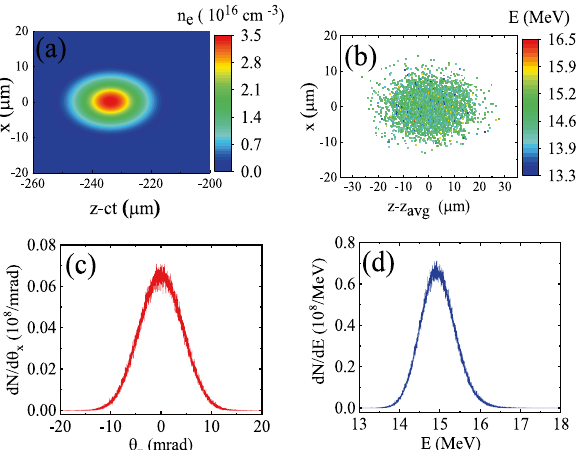
Figure 2. ( a ) Density distribution of a 15 MeV bi-Gaussian witness electron beam with the peak density n = 3.5 × 10 16 cm − 3 , which is initially placed 200 μm behind the peak of the laser pulse. The radii of the b0 injected bunch in the longitudinal and transverse directions are σ z = 8 μm and σ x = 4 μm, respectively; ( b ) Spatial distribution of the electron bunch injected in the simulations; ( c ) Distribution of the inclination angle θ x ; ( d ) Corresponding energy